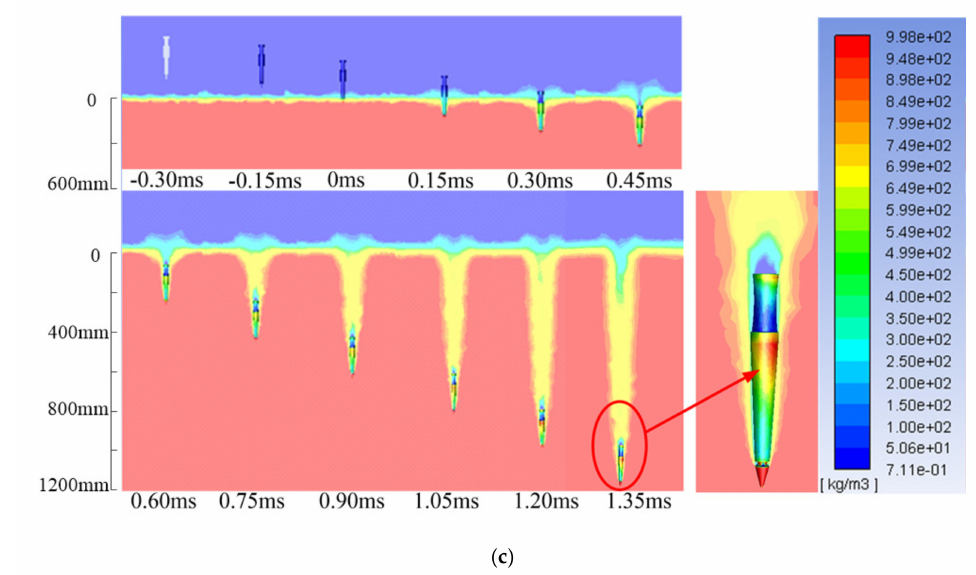
Figure 23. Contours of the cavity of vertical water-entry with di ff erent r : ( a ) r = 0.5 mm; ( b ) r = 1.0 mm; ( c ) r = 1.5